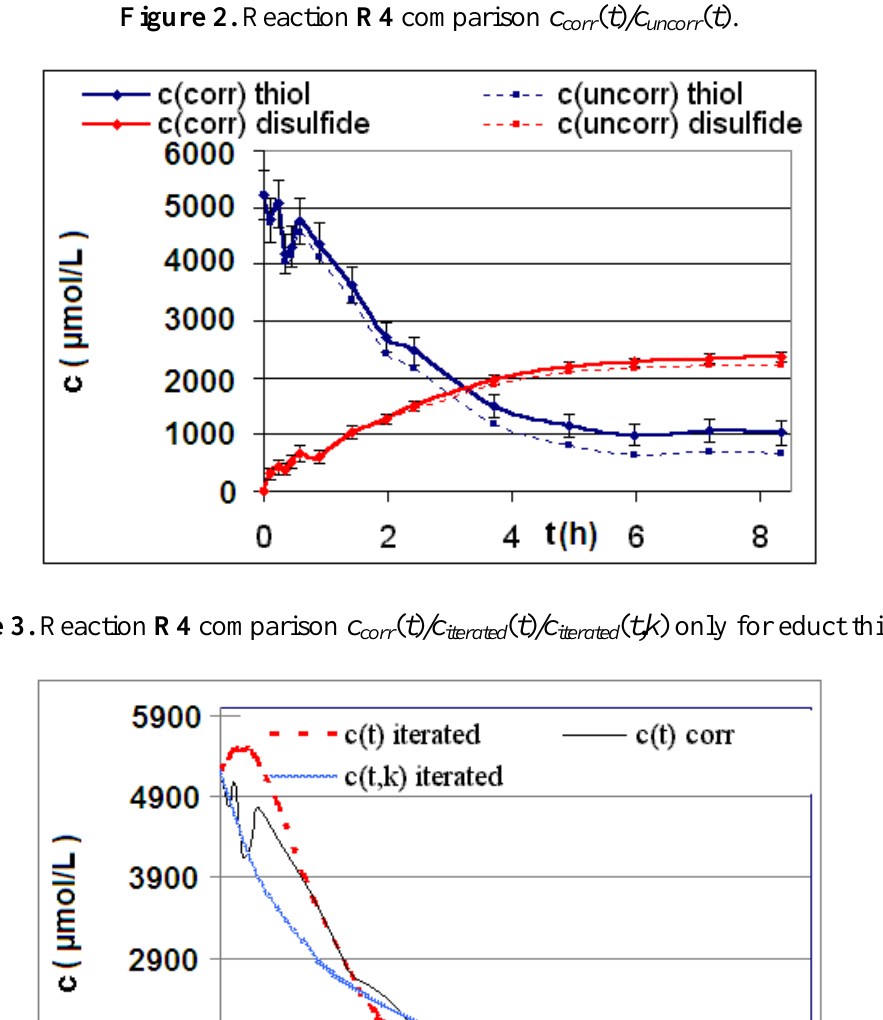
Figure 2. Reaction R4 comparison c